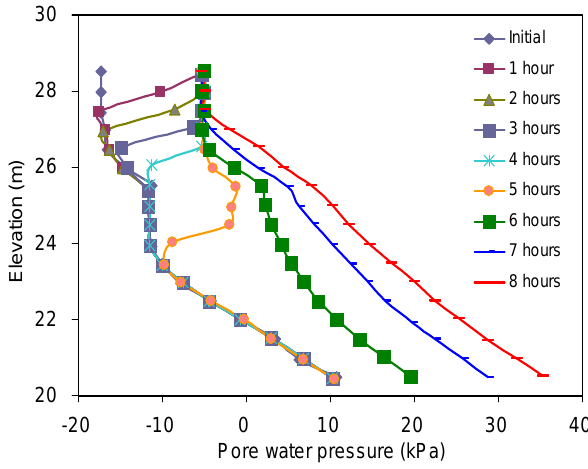
Fig. 10. Change of pore-water pressure with time during rainfall infiltration in a 40 ◦ infinite slope.